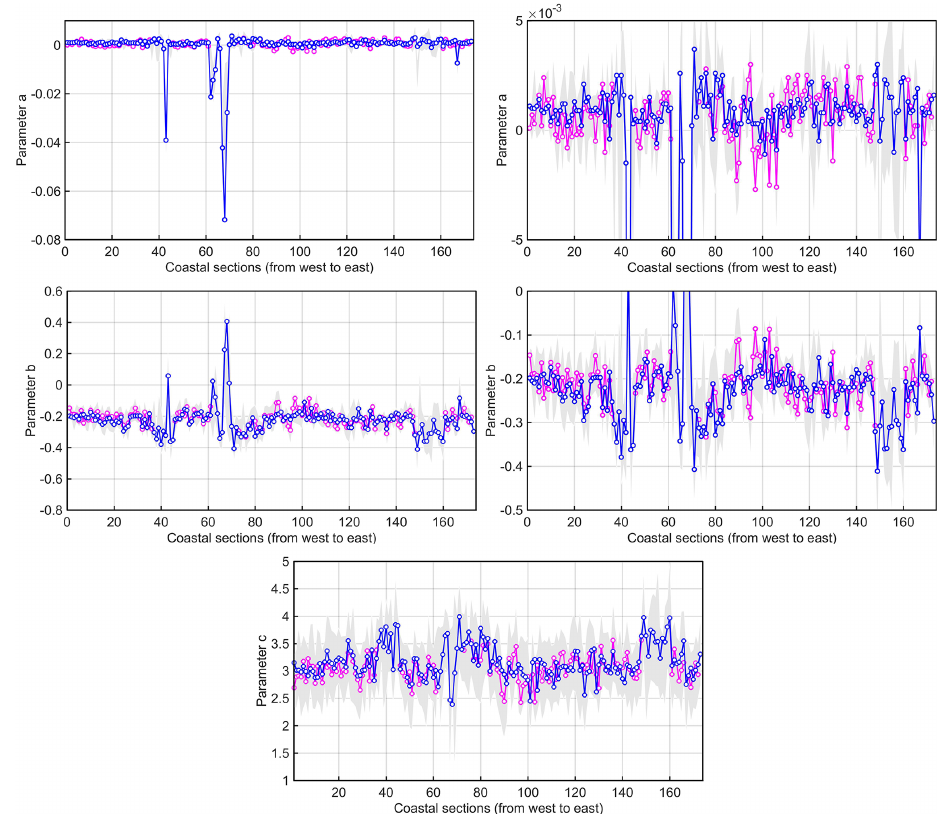
Figure 9. Alongshore variation of the coefficients a , b , and c of the quadratic approximation az 2 + bz + c of the exponent of empirical distributions of set-up heights in the Tallinn Bay area. For the parameters a and b , more detailed alongshore variation is presented in graphs with vertically stretched scales. Blue line: the respective parameter calculated for the range of set-up heights from 0.01m to the first gap in the empirical distribution; the grey area marks the 95% confidence interval of this value, and the pink line describes the values of the relevant parameter for the range of set-up heights from 0.01 to